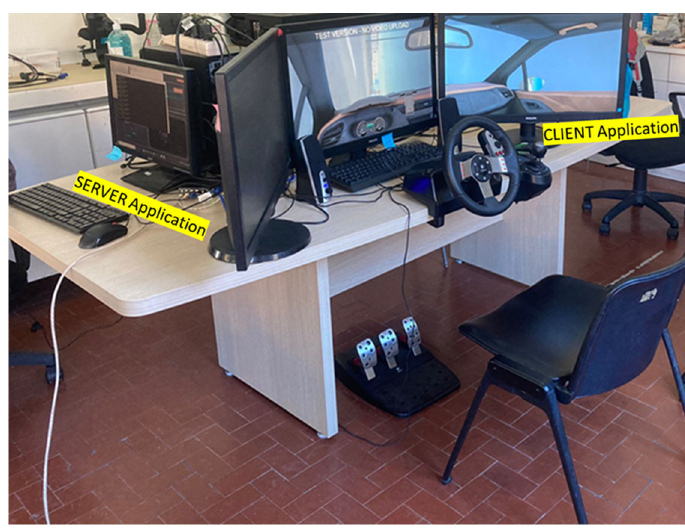
Figure 2. Car simulator. The SERVER and CLIENT applications have been highlighted.